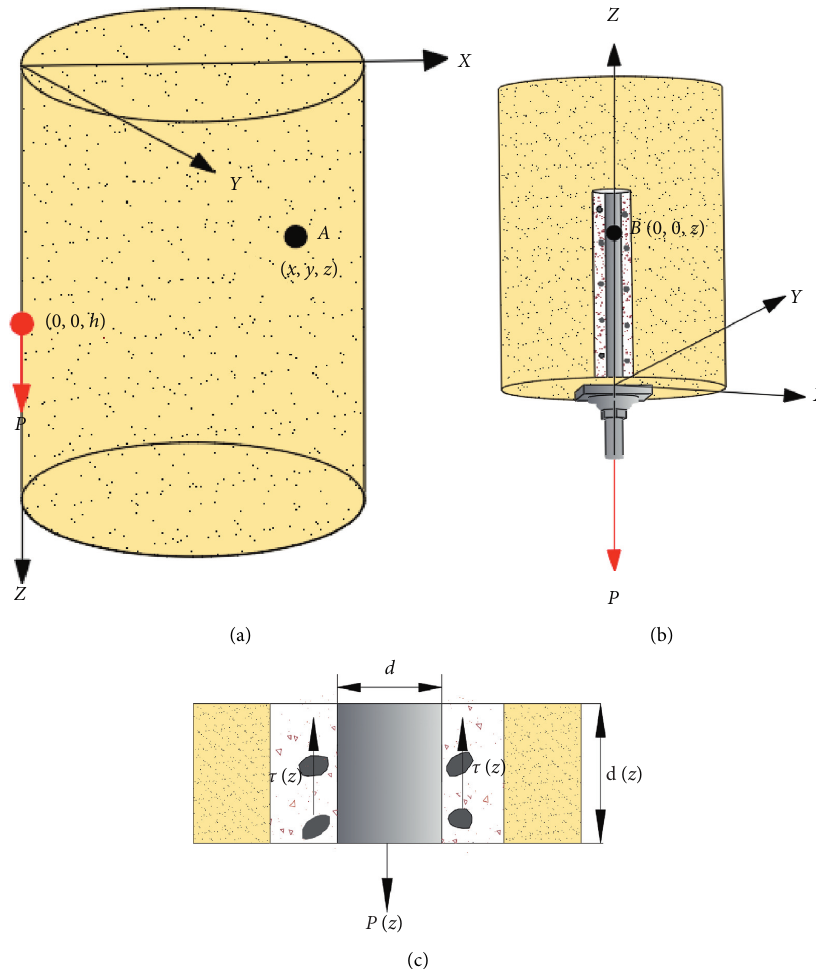
Figure 3: Mechanical model of bolt axial force distribution under the condition of resin grout with aggregate. (a) Calculation model of Mindlin displacement solution; (b) simplified calculation model; (c) diagram of microelement stress